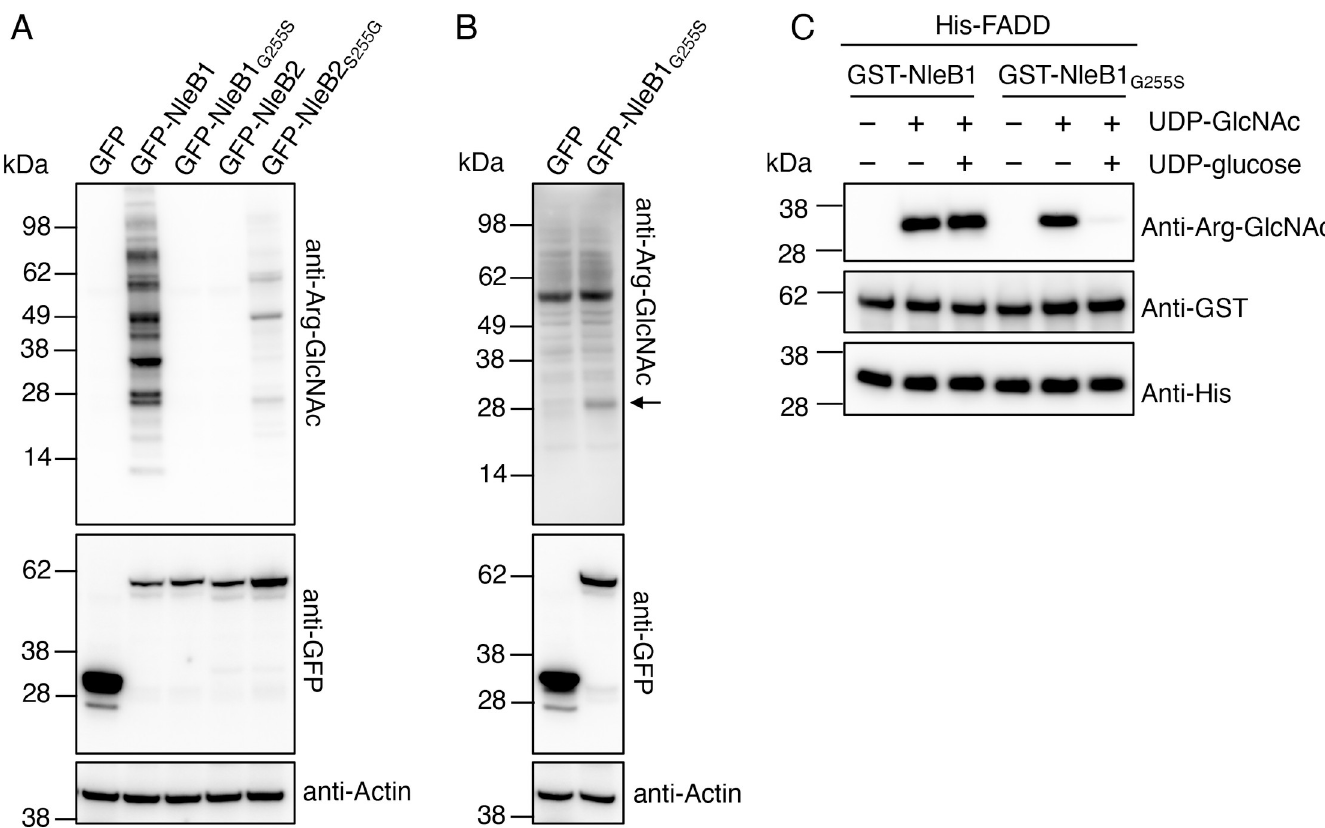
Fig 6. Mutation of Glycine 255 in NleB1 switches sugar donor preference to UDP-glucose. (A) HEK293T cells were transfected with either pEGFP-C2, pGFP-NleB1, pGFP-NleB1 G255S , pGFP-NleB2 or pGFP-NleB2 S252G before being lysed and subjected to PAGE and immunoblot with anti-Arg-GlcNAc and anti-GFP antibodies. Anti- Actin antibodies were used as a loading control. Anti-Arg-GlcNAc immunoblot was developed with routine detection reagents. Representative immunoblots of 3 independent experiments. (B) HEK293T cells were transfected with either pEGFP-C2 or pGFP-NleB1 G255S before being lysed and subjected to PAGE and immunoblot with anti-Arg-GlcNAc and anti-GFP antibodies. Anti-Actin antibodies were used as a loading control. Anti-Arg-GlcNAc immunoblot was developed with highly sensitive detection reagents. Representative immunoblots of 3 independent experiments. (C) In vitro sugar donor competition assays. His-FADD was incubated with GST-NleB1 or GST-NleB1 G255S either without sugar donors, or in the presence of 25 μ M UDP-GlcNAc alone or in combination with 25 μ M UDP-glucose. Proteins were subjected to PAGE and immunoblot with anti-Arg-GlcNAc, or anti-His and anti-GST antibodies as controls. Representative of at least 3 experiments. co-incubation with 1 μ M MBP-RIPK1 (S9A Fig). Therefore, we performed all enzymatic DD kinetic analysis and Km calculations on reactions that included MBP-RIPK1 as a protein DD target (S9B and S9C Fig). We found that NleB1 and NleB1 were generally more efficient G255S at utilising either UDP-linked sugar compared to NleB2 and NleB2 under the conditions S252G tested, with higher Vmax and lower Km values determined overall (S9 and S9C Fig). As expected, we observed no UDP release in the reactions using catalytically inactive NleB1 DXD or NleB2 (S9B Fig). Km and Vmax calculations performed using Michaelis-Menten equa- DXD tions confirmed that NleB2 and NleB1 used UDP-glucose more efficiently than UDP-Glc- G255S NAc, while the reverse was true for NleB2 and NleB1 (S9C Fig). Interestingly, the enzyme S252G that utilised UDP-glucose most efficiently under the conditions tested was NleB1 , which G255S had a Km of 4.5 μ M with UDP-glucose, compared to NleB2 which was determined to have a Km of 32.9 μ M with UDP-glucose (S9C Fig). It is possible that other residues in NleB2 influ- ence the target binding affinity of NleB2 for MBP-RIPK1 compared to NleB1. Such differ- DD ences in protein target specificity may explain the differing enzymatic efficiencies between NleB1 and NleB2 in the conditions tested here.